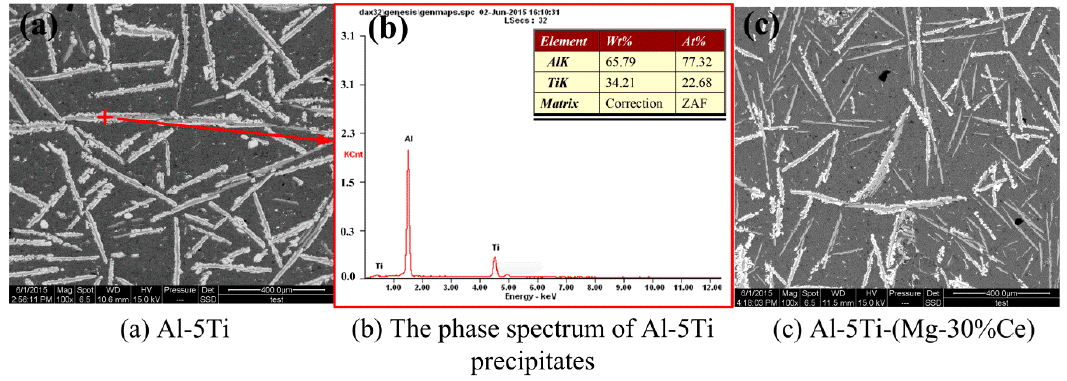
Figure 5. Scanning electron microscope and energy spectrum analysis images of Al–5Ti– x (Mg–30%Ce).